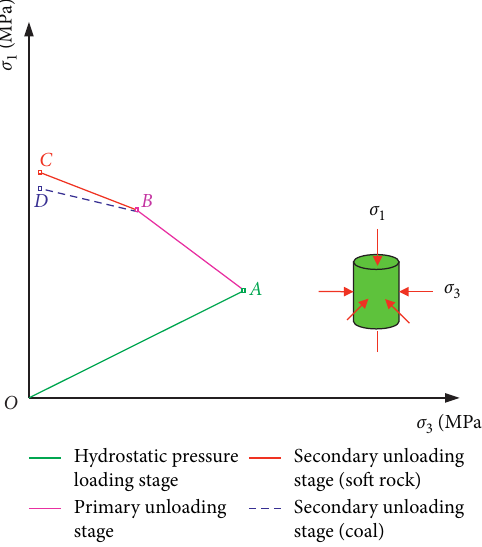
Figure 5: Mining-induced mechanics stress path.